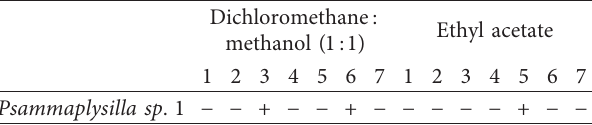
Figure 6: Antifungal activity of ethyl acetate (EA) and dichloromethane:methanol (DCM: ME) crude extracts against C. albicans . Table 2: Phytochemical screen Psammaplysilla sp. 1 isolated from Phillips Reef, Port